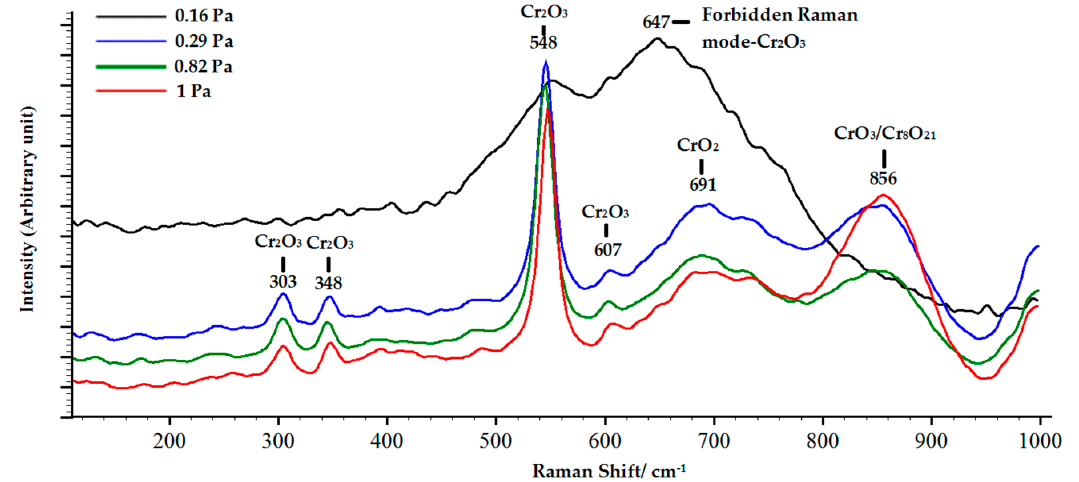
Figure 3. Raman spectra of chromium oxide coatings deposited at different pressures.